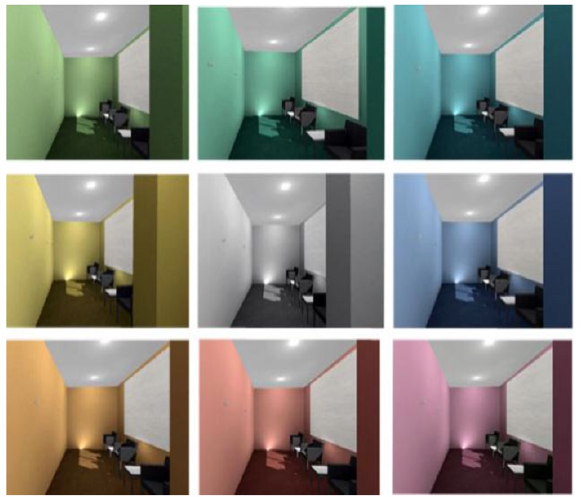
Figure 10. 3D model and virtual reality applied to a lactation room in the Maternity Unit at the Hospital Príncipe de Asturias, Alcalá de